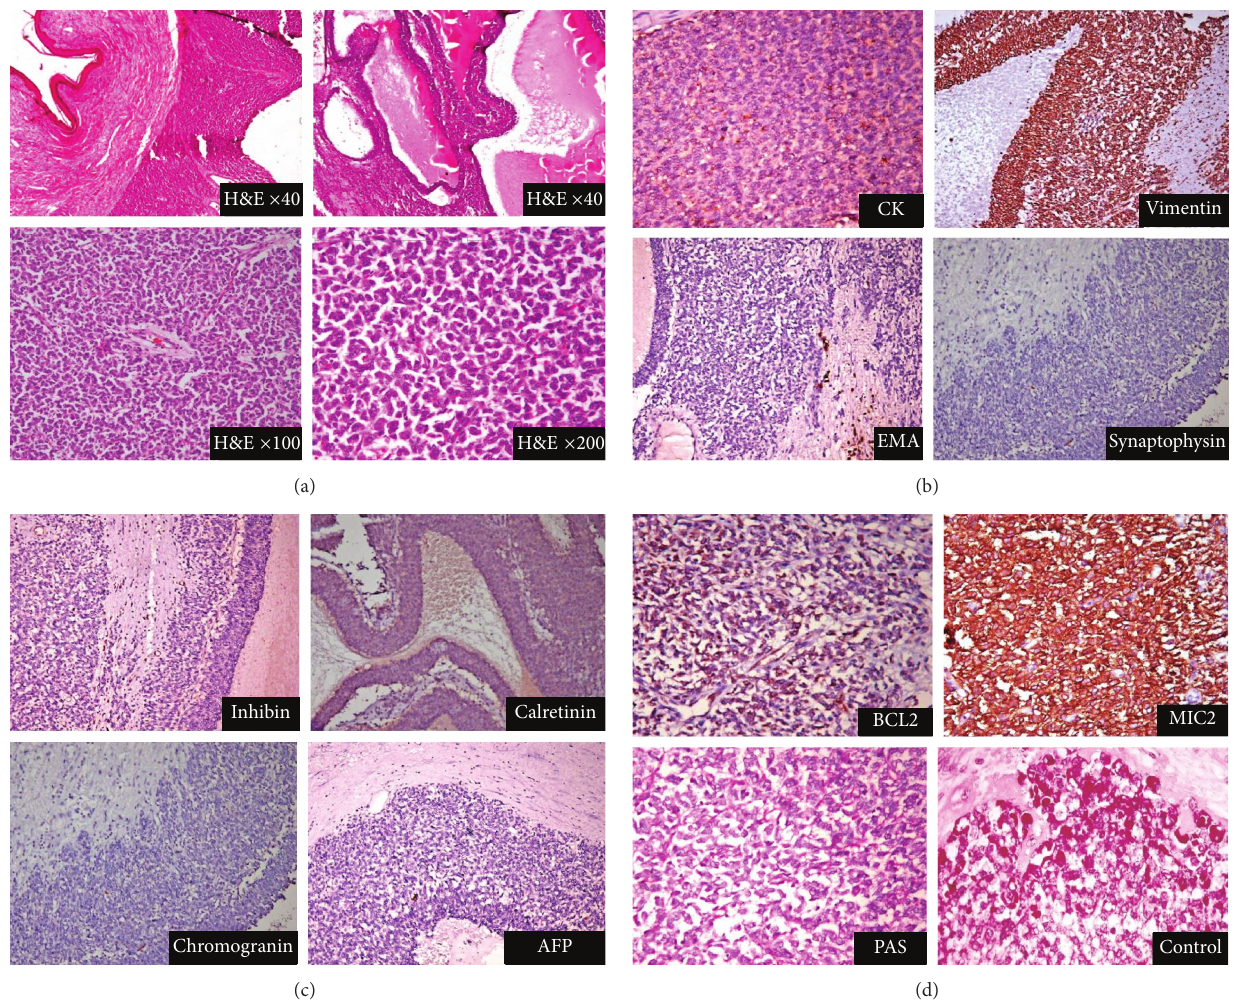
Figure 6: H&E staining revealed poor differentiation and the tumour was immunopositive for vimentin, cytokeratin (focal), Bcl2, and MIC2.